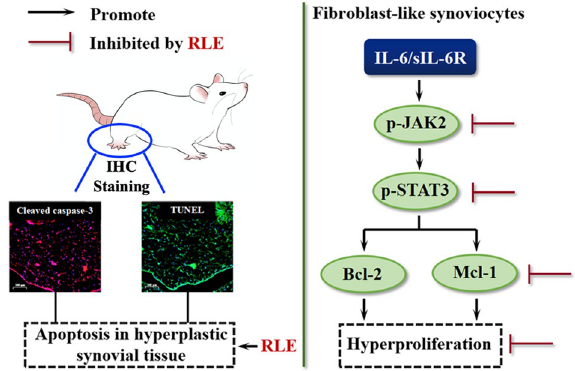
Figure 7. Effects of RLE on hyperproliferation of